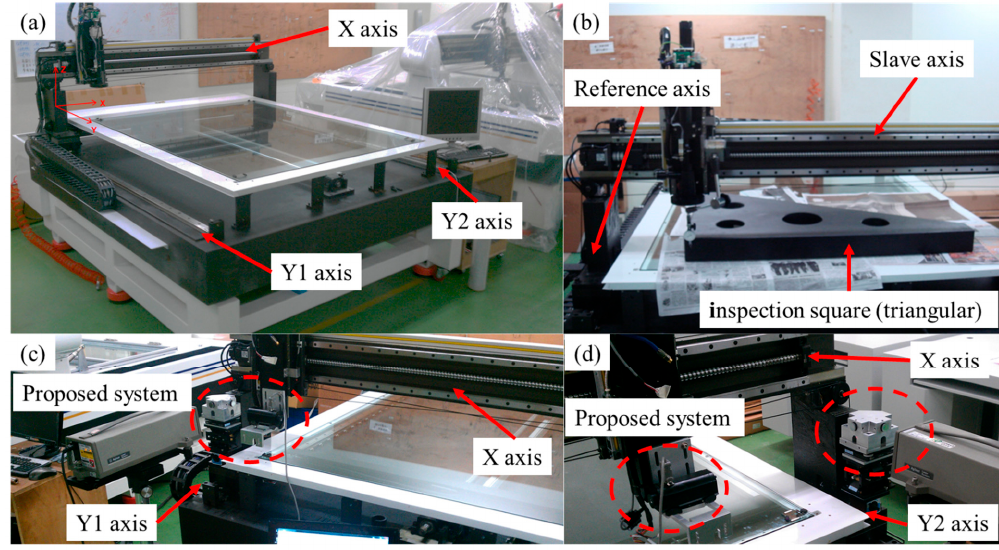
Figure 22. Case 3 perpendicular error measurement setup. ( a ) The Automated optical inspection (AOI) equipment to be measured, ( b ) the inspection square (triangular) measurement setup, ( c ) the Y1 ┴ X measurement setup of proposed system, and ( d ) the Y2 ┴ X measurement setup of proposed system.